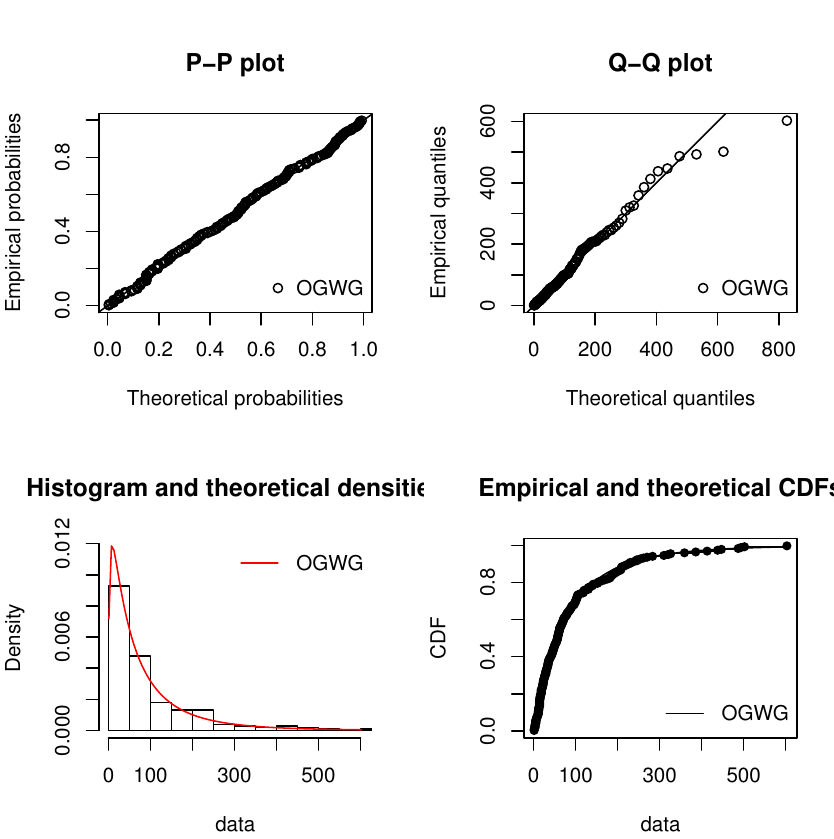
Figure 3. ( a ) Boxplot and ( b ) TTT plot for data set 1.